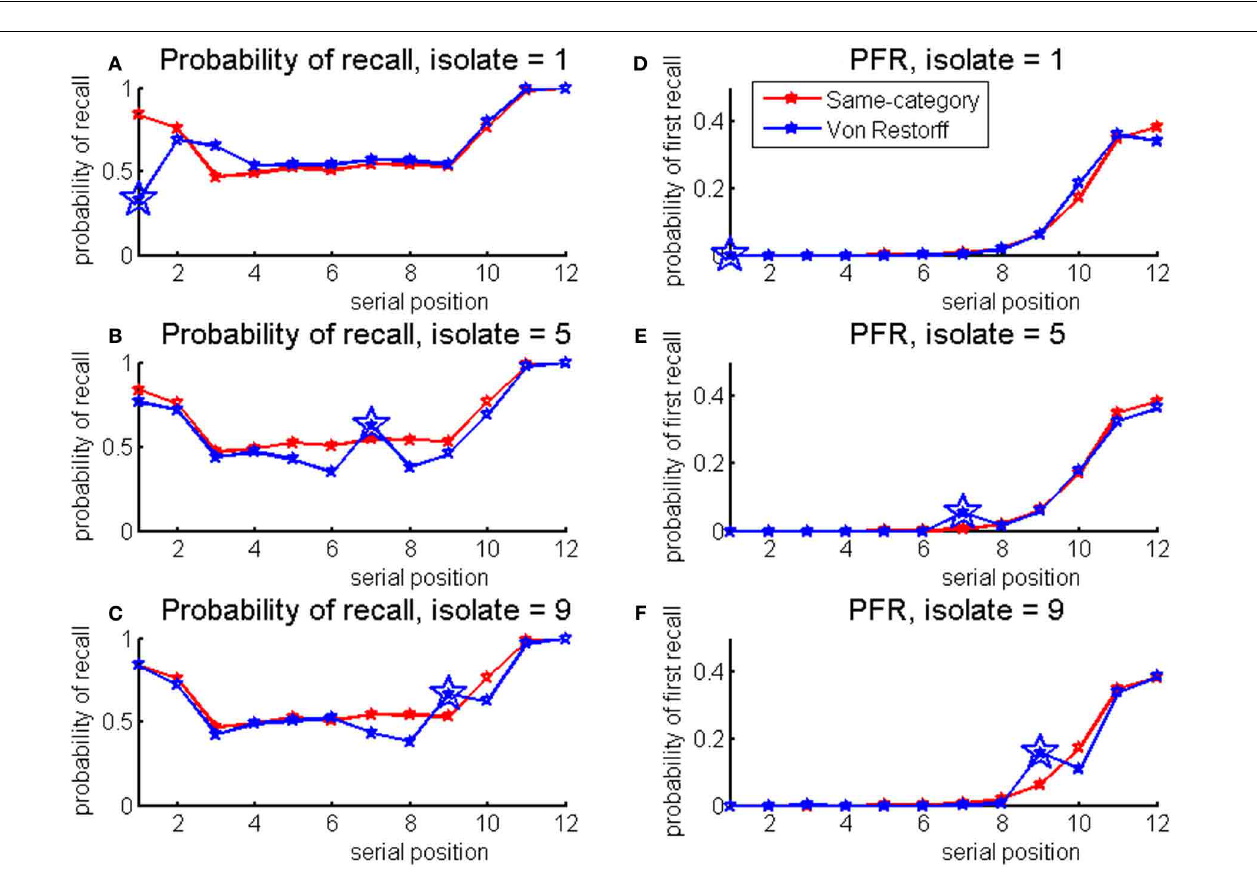
It can be seen that the isolate is better recalled in the model with the PFC mechanism and this advantage depends on its serial position as predicted.